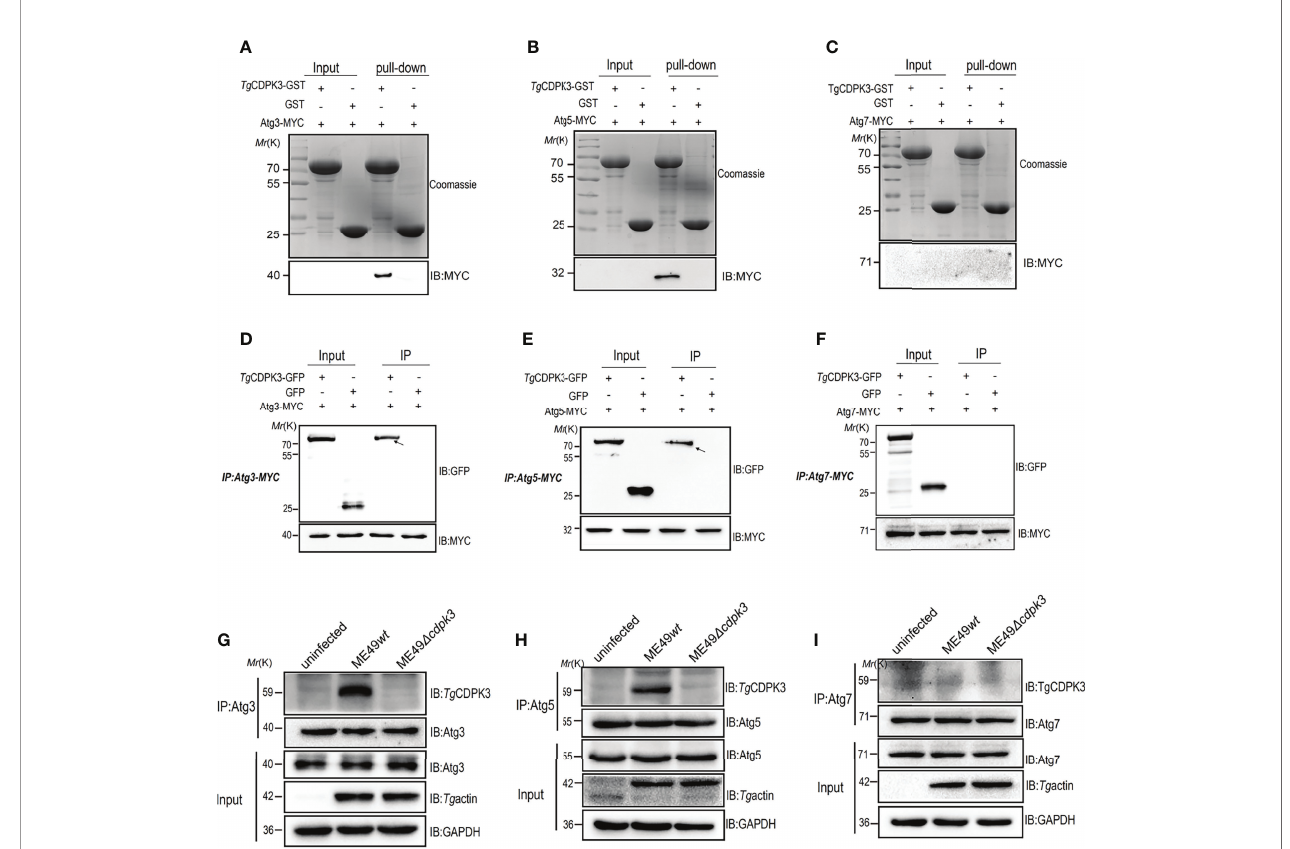
FIGURE 4 | Con fi rmation of the interaction of Toxoplasma gondii CDPK3 with Atg3 and Atg5. (A – C) Con fi rm the binding of CDPK3 to Atg3 and Atg5 in vitro pull-down assay. GST-CDPK3 puri fi ed on glutathione beads is used as an af fi nity matrix for Atg3, Atg5 or Atg7. Coomassie brilliant blue staining (upper image), Western blot (MYC tag antibody, lower image) (D – F) Verifying that CDPK3 interacts with Atg3 and Atg5 through immunoprecipitation. CDPK3-GFP or control GFP vector with Atg3-MYC, Atg5-MYC, or Atg7-MYC co-transfected into HEK 293T cells. The arrow indicates that CDPK3 (uppe panel) and Atg3-MYC and Atg7-MYC (lower panel) are immunoprecipitated together. (G – I) ME49 wt and ME49 D cdpk3 strain respectively infected RAW264.7 cells to determine CDPK3 and Atg3 and Atg5 interaction (Moi = 3). At 4 h after infection, rabbit polyclonal CDPK3 antibody was used to detect the immunoprecipitation (IP) of Atg3, Atg5 and Atg7 from the lysate of infected